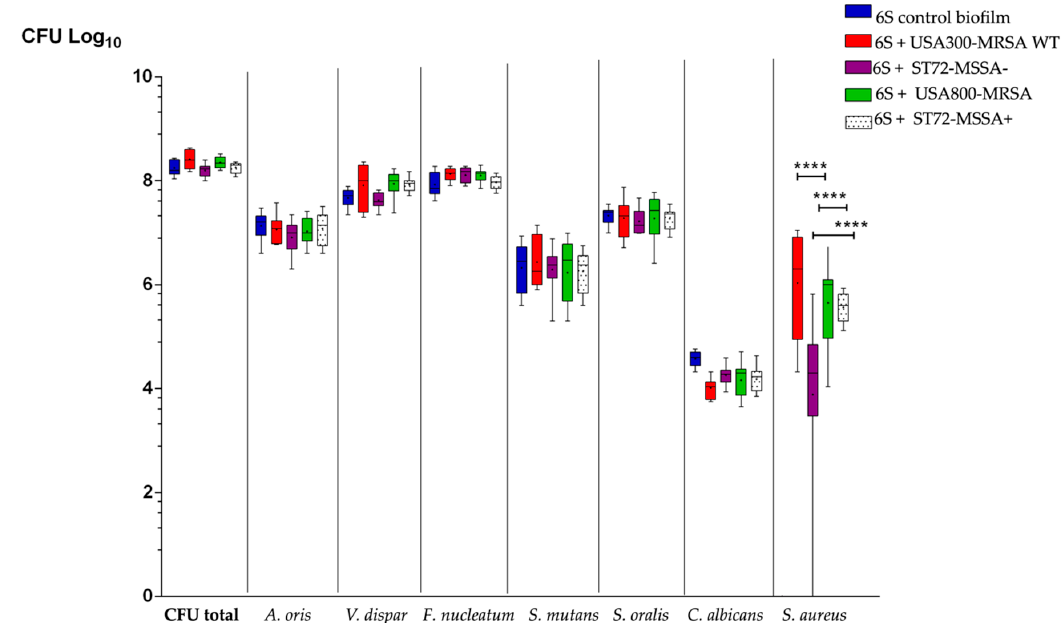
Figure 1. Boxplots with median and interquartile ranges present the impact of various S. aureus strains on the growth of supragingival-associated oral species. Quantification was performed using species-specific culture analysis. The 6S control biofilms are presented in blue, the 6S + USA300-MRSA WT (wild type S. aureus ) strain in red, the 6S + ST72-MSSA (methicillin-sensitive S. aureus strain PN35, PVL negative) in purple, the 6S + USA800-MRSA (methillicin-resistant S. aureus HU13N, PVL negative) in green, and the MSSA-OMZ1122, PVL positive is presented in white/dotted. The data are expressed as the bacterial mean counts ± SD from nine biological replicates, presented on a log 10 scale per milliliter. Highly significant differences were detected between USA300-MRSA WT and ST72-MSSA-, as well as between ST72-MSSA- and USA800-MRSA, and ST72-MSSA- and ST72-MSSA+ (ANOVA test: **** p < 0.0001). No significant differences were found between USA300-MRSA WT and USA800-MRSA, USA300-MRSA WT and ST72-MSSA+, and USA800-MRSA and ST72-MSSA+.